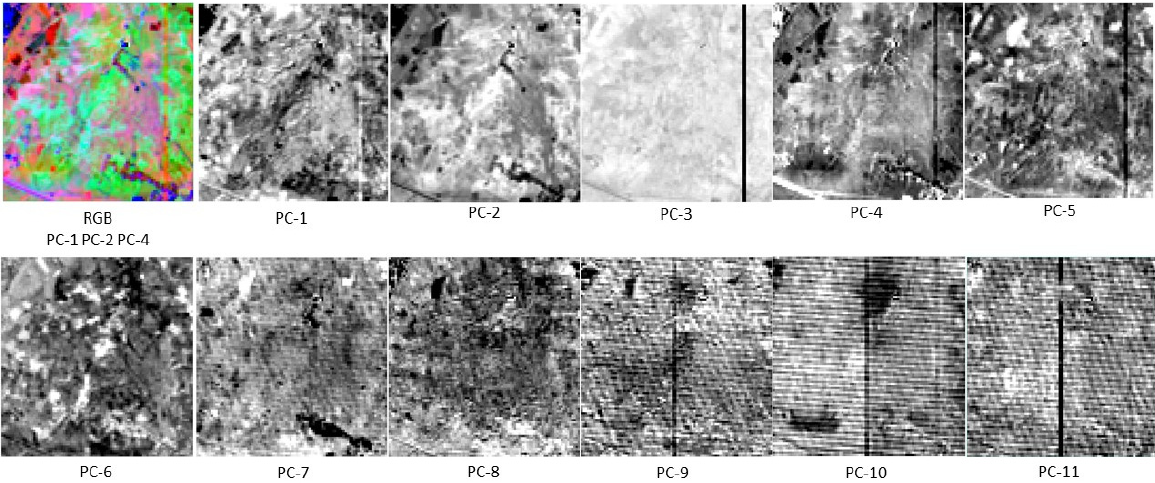
Figure 11. Alba Fucens’ principal component analysis: synthetic bands obtained by the hyper ‐ spectral PRISMA VNIR dataset. Notice that the information from the PC ‐ 10 can be assimilated to noise.